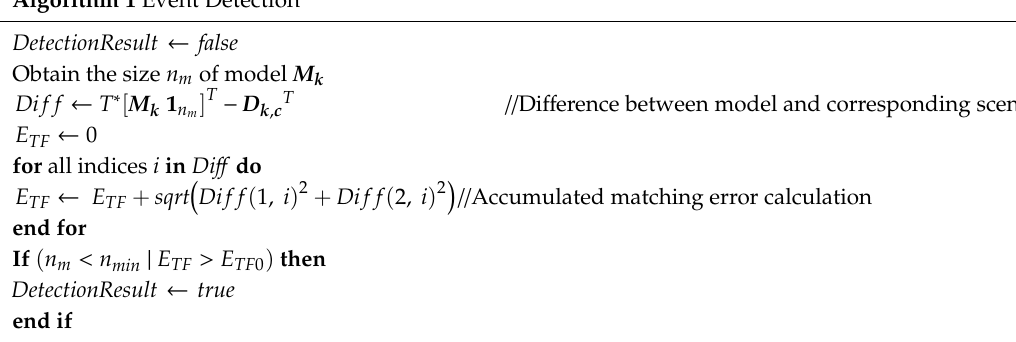
Algorithm 1 Event Detection